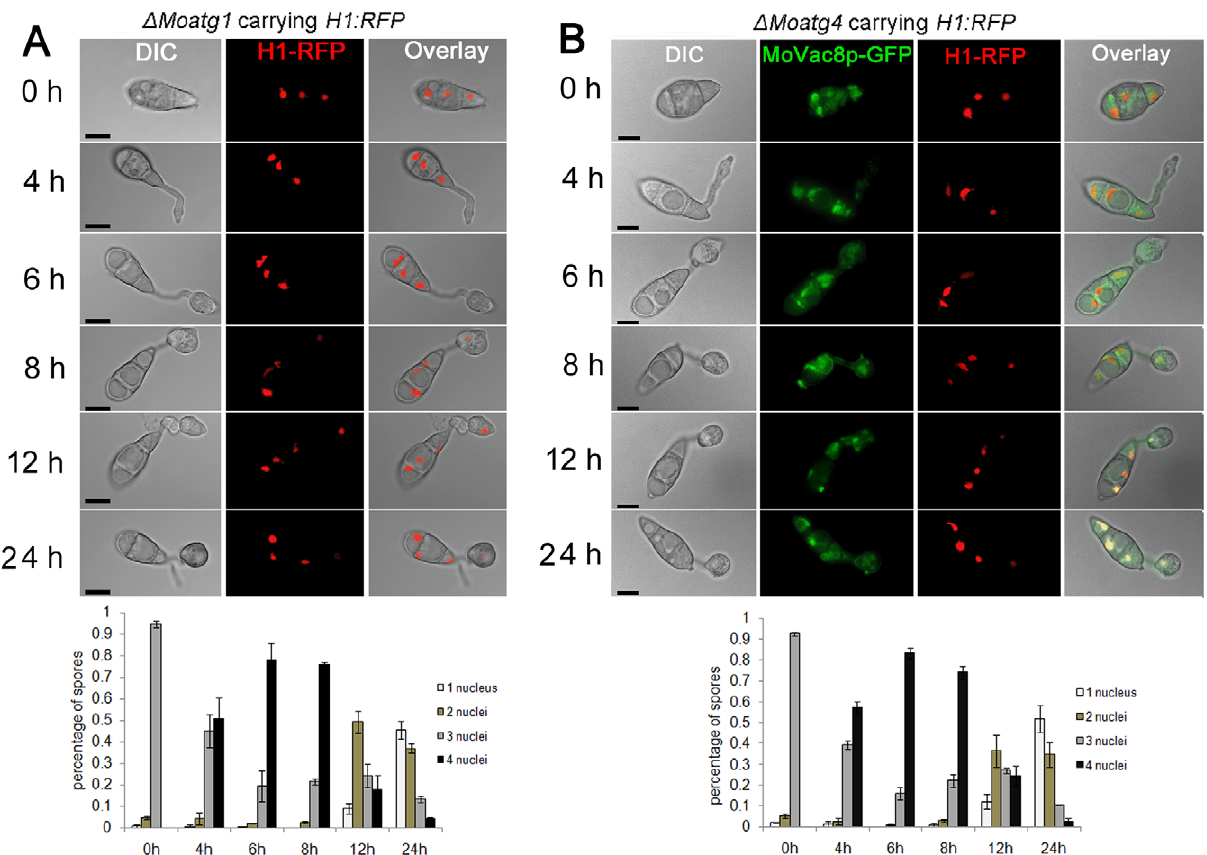
Figure 10. Macroautophagy is necessary for nuclear degeneration during appressorium development in M. oryzae . ( A ) The Macroautophagy gene MoATG1 is required for nuclear degeneration. Upper panel: time course live cell images showing nuclear division and nuclear degeneration during appressorium development in a M. oryzae D Moatg1 mutant. D Moatg1 conidia expressing H1:RFP were examined by epifluorescence microscopy at indicated time points. Lower panel: time series of bar charts showing the percentage of spores in D Moatg1 containing 0 to 4 nuclei (mean 6 SD, n . 100, triple replications). ( B ) The Macroautophagy core gene MoATG4 is required for nuclear degeneration. Upper panel: time course live cell images showing nuclear division and nuclear degeneration during appressorium development in M. oryzae D Moatg4 mutant. D Moatg4 conidia expressing H1:RFP were examined by epifluorescence microscopy at indicated time points during appressorium development. Lower panel: time series of bar charts showing the percentage of spores in D Moatg4 containing 0 to 4 nuclei (mean 6 SD, n . 100, triple replications). Scale bar=10 m m.